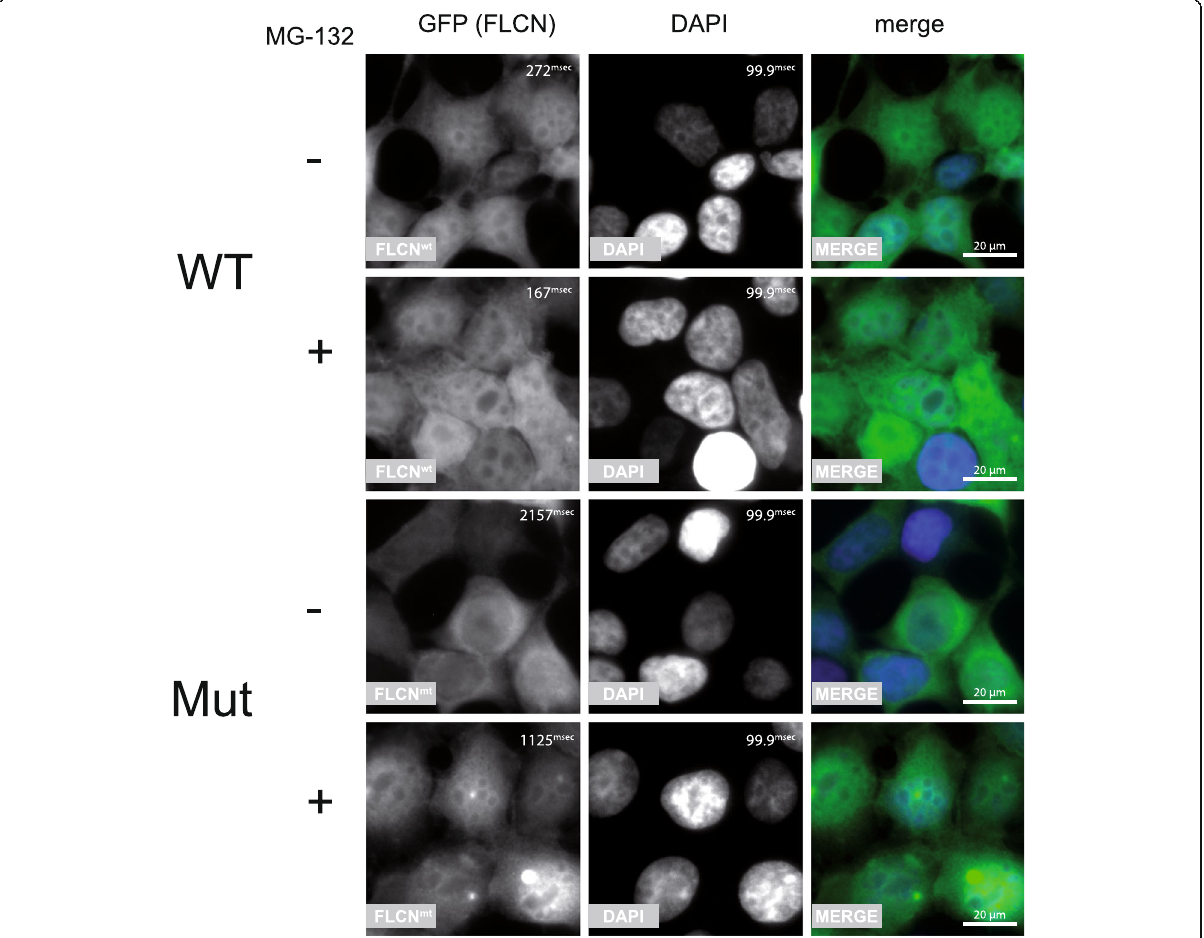
Fig. 6 HEK293T cells expressing FLCN WT or Mut fused to GFP using the TALEN technology were subjected to immunofluorescent imaging. WT FLCN localizes to both cytoplasm and nucleus, the mutant protein is primarily found in the cytoplasm. Interestingly treatment with MG-132 did not only stabilize the mutant protein which is reflected by a shorter exposure time during image acquisition but also led to a nuclear shift making its localization more similar to the WT protein (bar = 20 μ m, exposure time of the GFP and DAPI channel are depicted in millisecond in the upper right corner of each